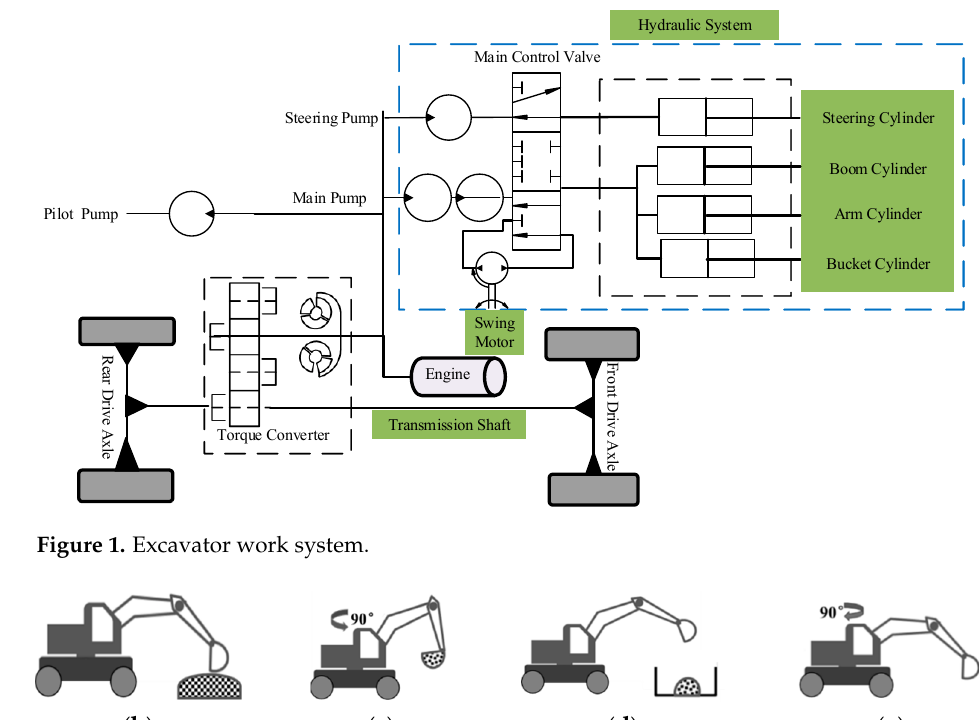
Figure 2. Operation stages of excavator. ( a ) Dig preparation; ( b ) digging; ( c ) lifting; ( d ) unloading; ( e ) swinging.